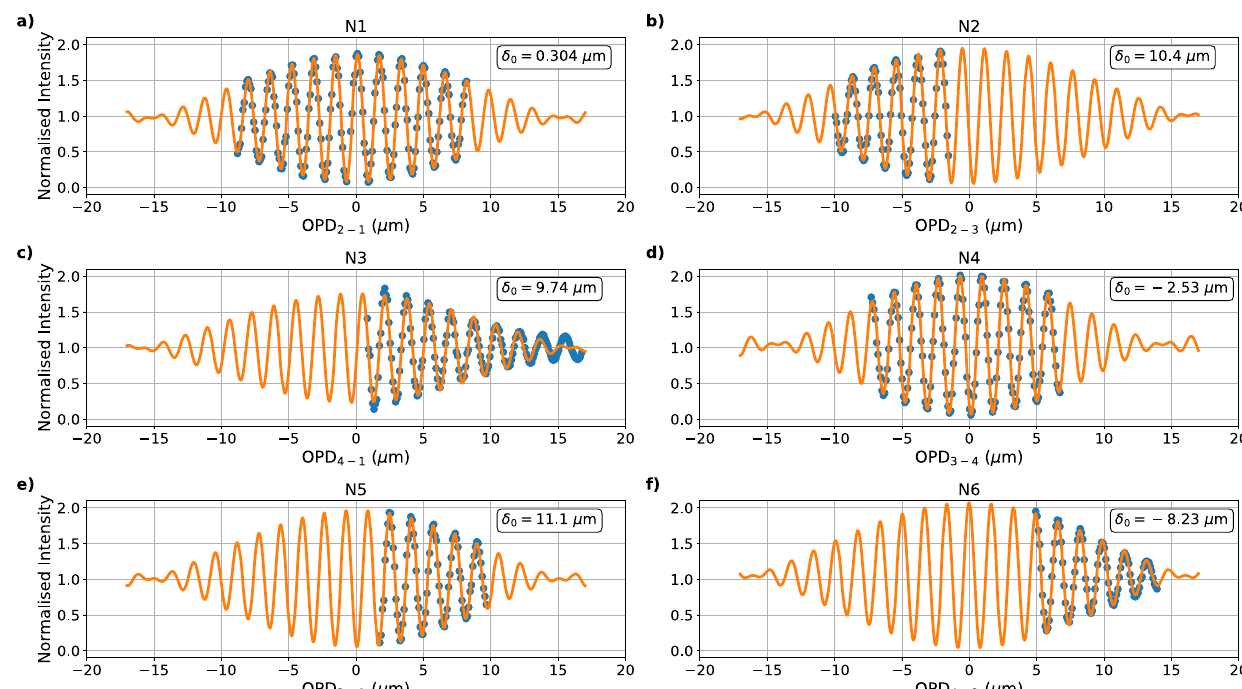
Fig. 3 Scanned fringe envelopes for each of the six baselines. Subplots ( a to f ) respectively represent the baselines N1 to N6 scanned over the full available range of the optical path difference (OPD) from data taken in July 2019 with illumination from the supercontinuum source within SCExAO. The blue dots are the data and the orange curve is the fi tted model. The label of the horizontal axis “ OPD x − y ” shows the segment of the beam x was scanned with respect to the reference beam y . The value in each plot is the fi tted δ 0 .